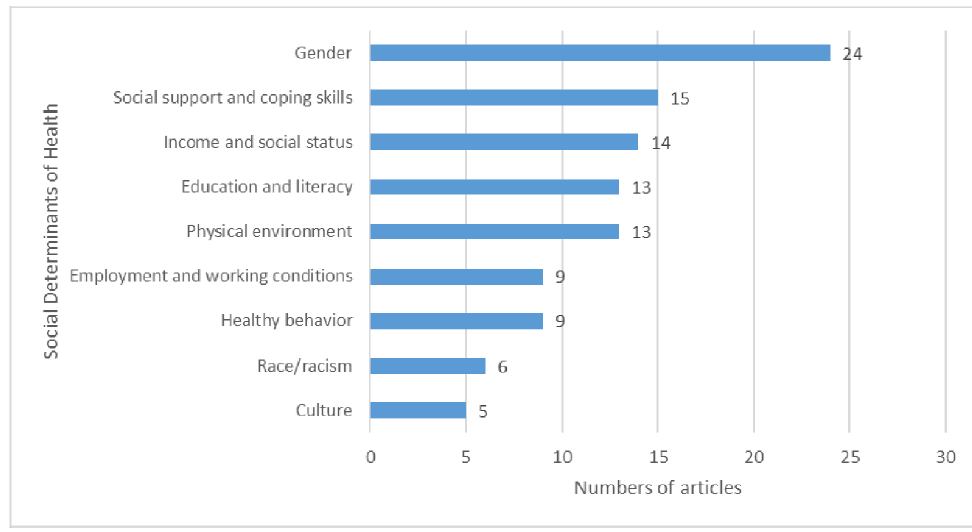
Figure 3. Social determinants of health (SDOH) represented across the 41 included articles examining physical activity or exercise among adults living with HIV. Given the heterogeneity of the study aims, study design and SDOH addressed across the articles, we describe results of the individual articles for each of the SDOH below.